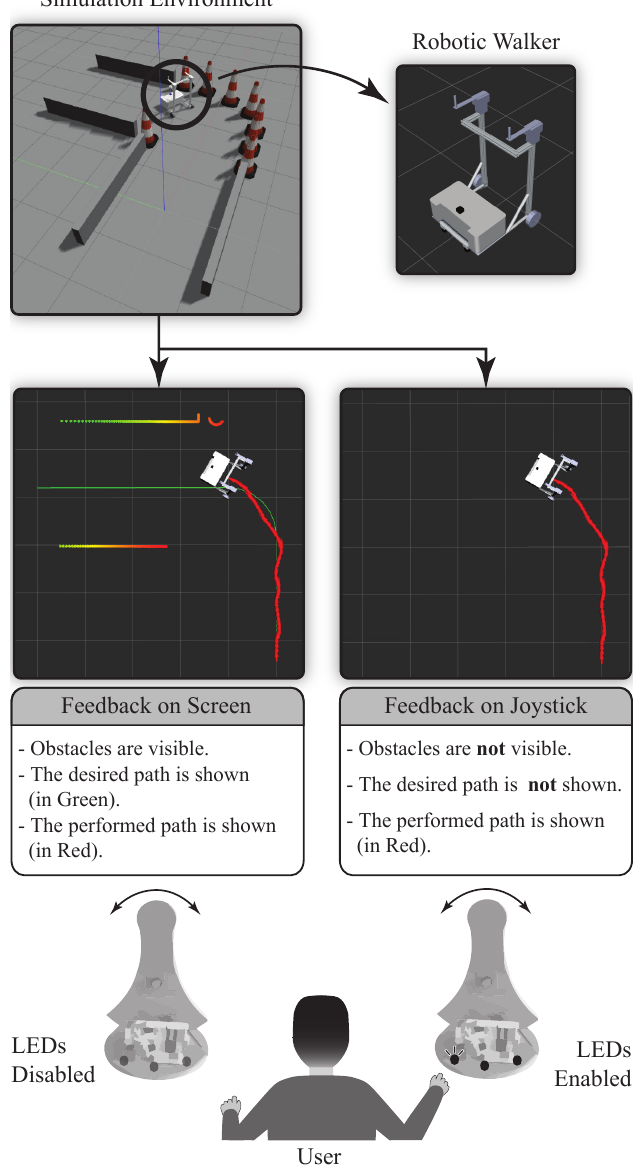
Figure 3. Visual feedback strategies applied in the robotic walker teleoperation. The upper figures show the simulation environment (gazebo) and the robotic walker used in the system. The central figures illustrate the ideal path and the proposed strategies with their characteristics in the graphic interface. The lower part exhibits the action on the joystick for each